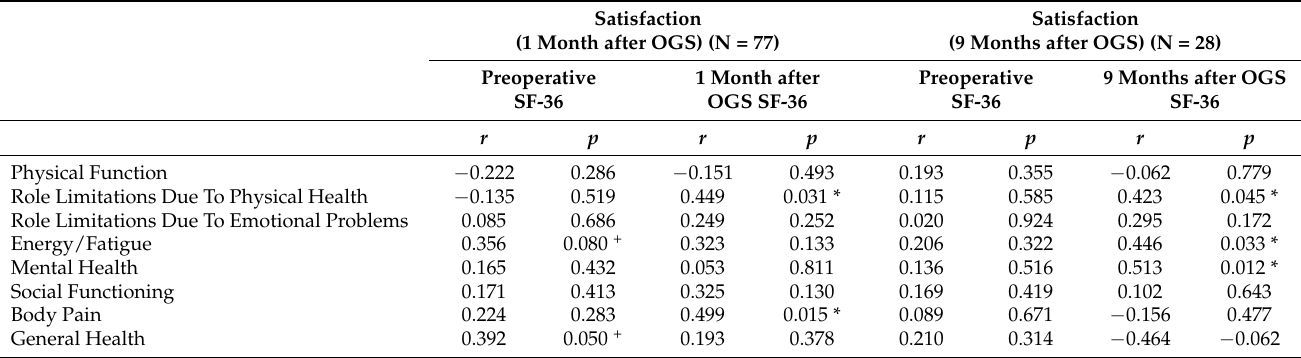
mental health ( r = 0.513, p = 0.012) were related with satisfaction nine months after OGS. Table 5. Correlation between SF-36 (preoperative, 1 month and 9 months after OGS) and surgical satisfaction. Satisfaction Satisfaction (1 Month after OGS) (N = 77) (9 Months after OGS) (N = 28)